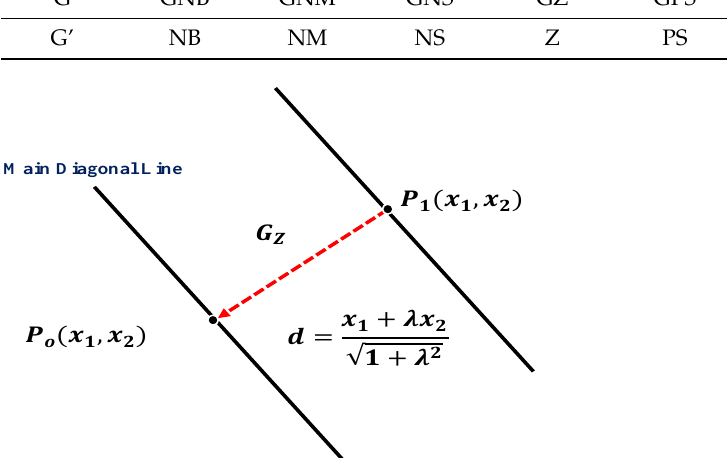
Figure 6. Graphical illustration for diagonal variable G.